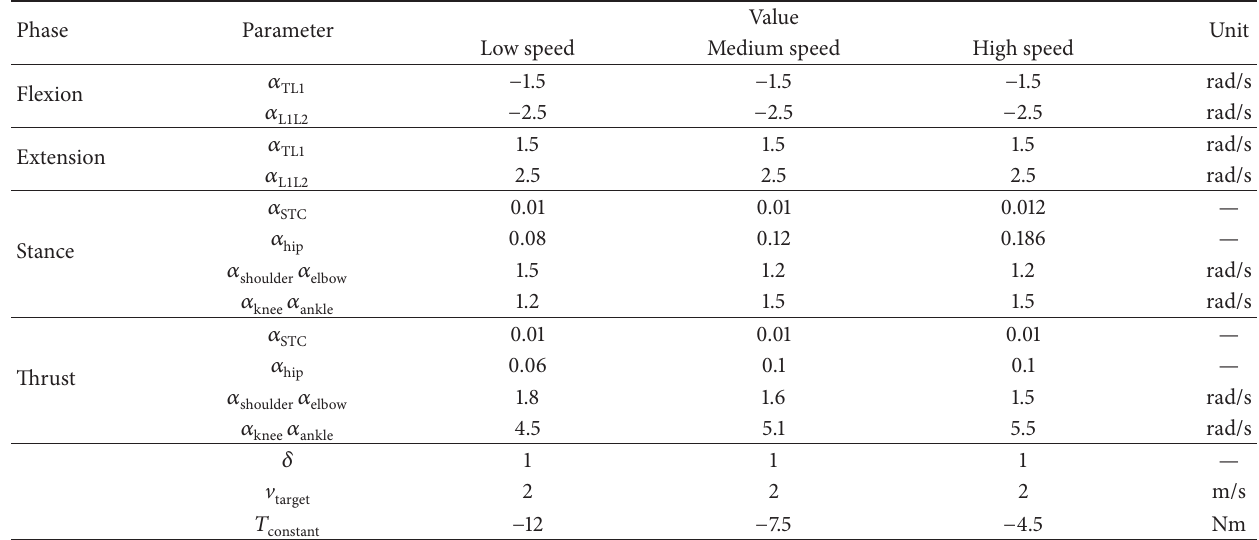
Table 5: Parameter values of different